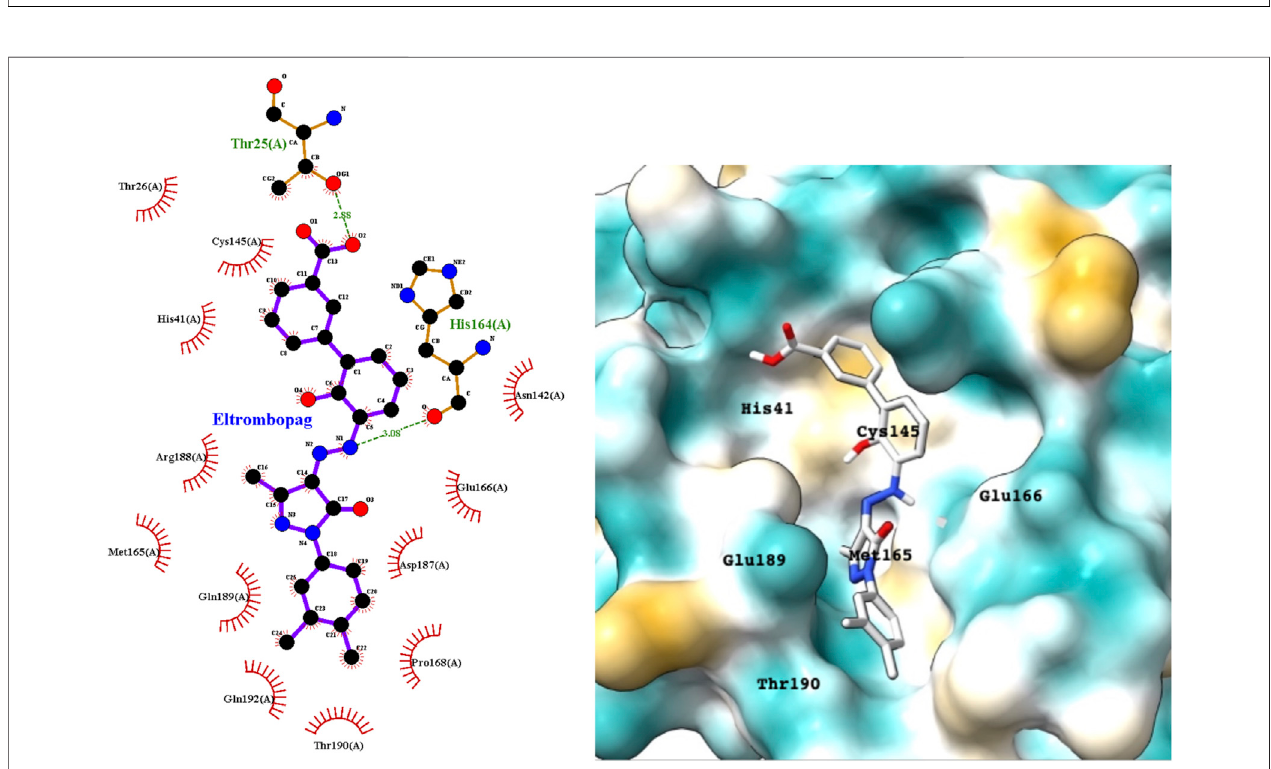
FIGURE 6 | LigPlot (left) and hydrophobic M pro protein surface representation (right) of the main interactions between M pro and eltrombopag and M pro . The molecular surface denotes hydrophobicity of the pockets (blue hydrophilic, yellow/brown hydrophobic).